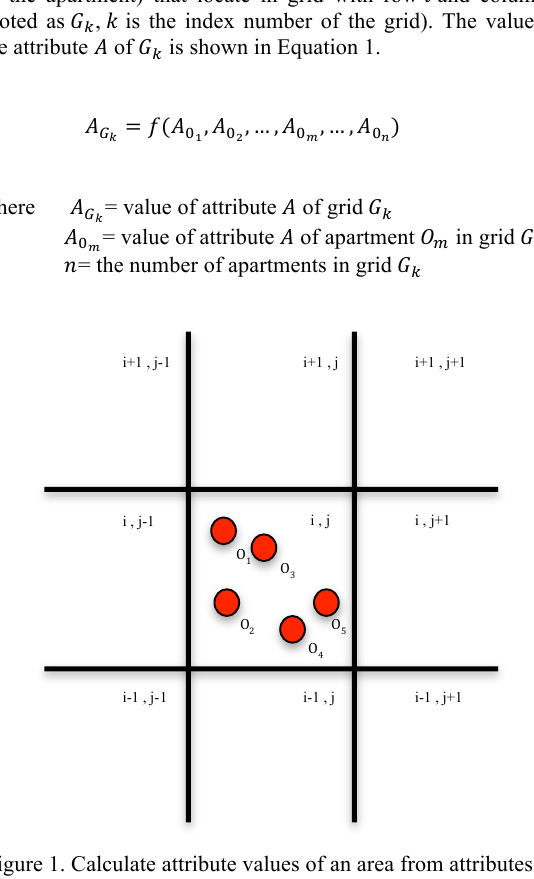
Figure 1. Calculate attribute values of an area from attributes of individual